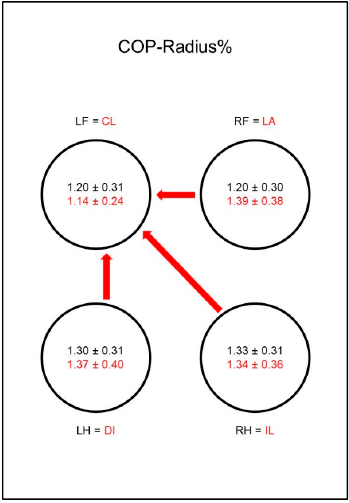
Figure 19. Mean distance of all center of pressure (COP) points to the center point of all COP points as a percentage of paw contact area (COP-Radius%) in study group 2 and control group. For detailed explanation and abbreviations refer to Figure 2. explanation and abbreviations refer to Figure